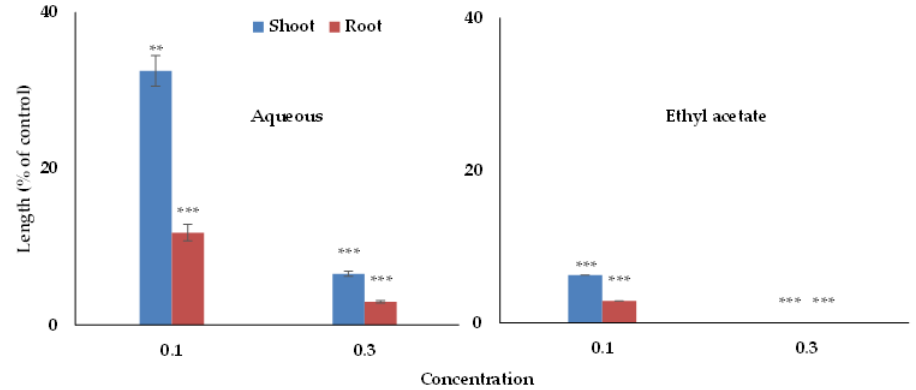
Figure 3. Effect on the seedling growth of cress of the aqueous and ethyl acetate fractions that has been obtained by partitioning of Wedelia chinensis extracts: cress was subjected to concentrations equal to 0.1 and 0.3 g DW extracts of Wedelia chinensis / mL. The values are mean ± SE for each treatment from two independent experiments with 10 seedlings. Asterisks show major variations between treatments and control: ** p < 0.01 and *** p < 0.001 (ANOVA one way and LSD test post